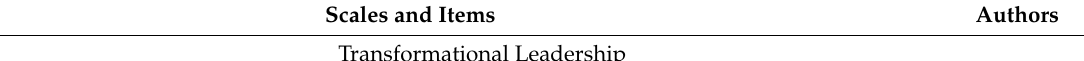
Table A1. The measurement scales.